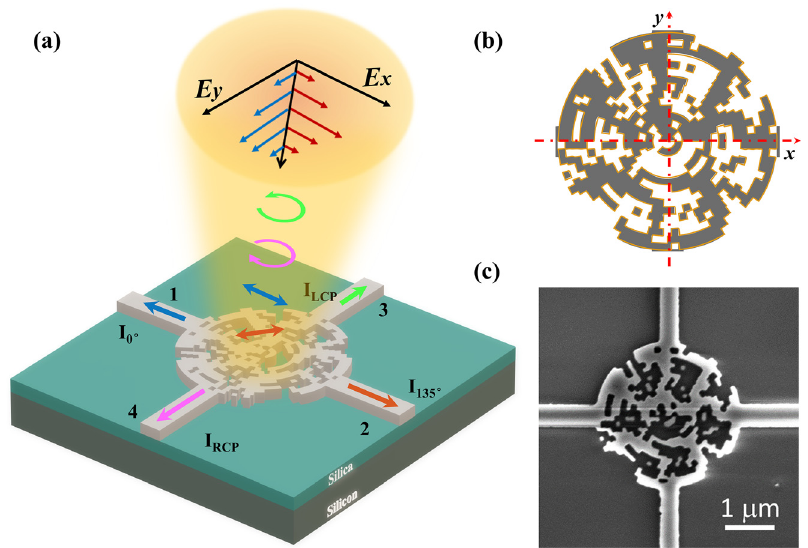
Figure 1: Structure design of the on-chip